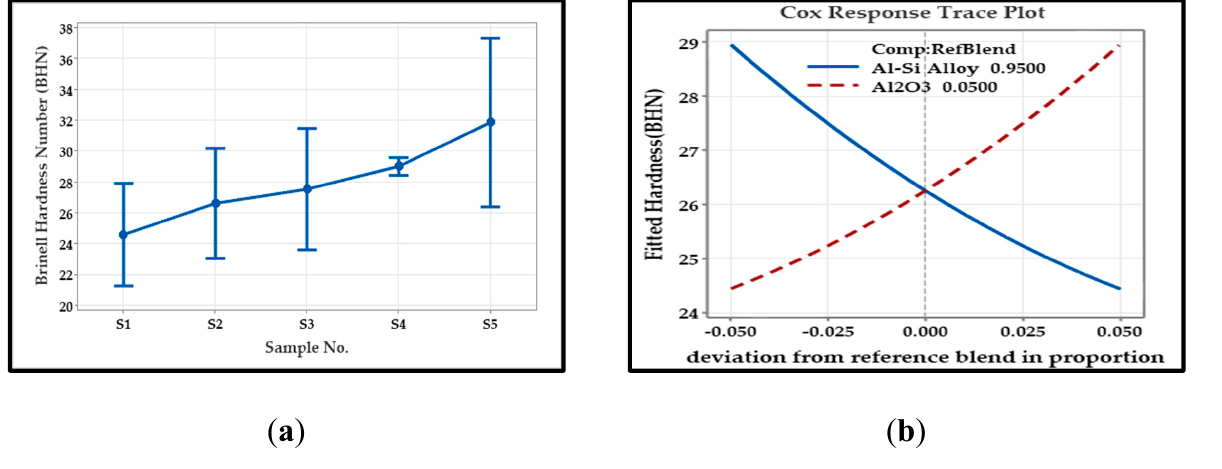
Figure 2. Brinell Hardness Number and Cox Response Trace plot of the Composite Material. ( a ) Hardness; ( b ) Cox Response Trace.